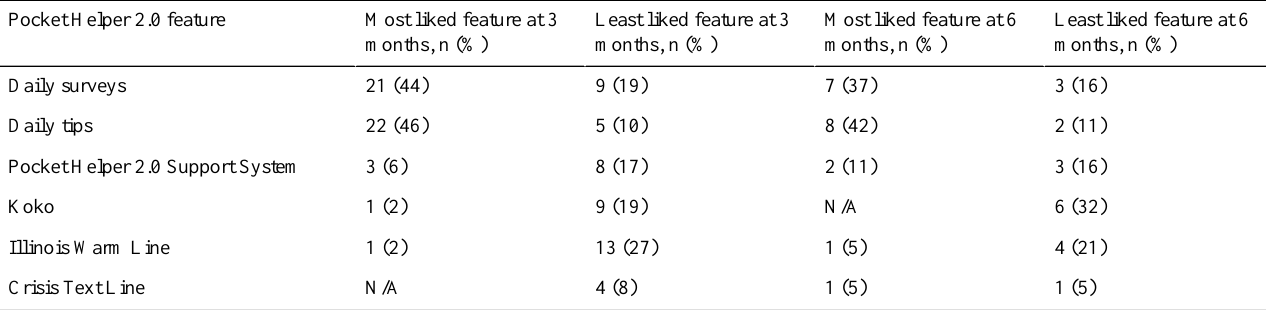
Table 3. Self-reported most and least liked features in Pocket Helper 2.0 app. (3 months, n=48; 6 months,